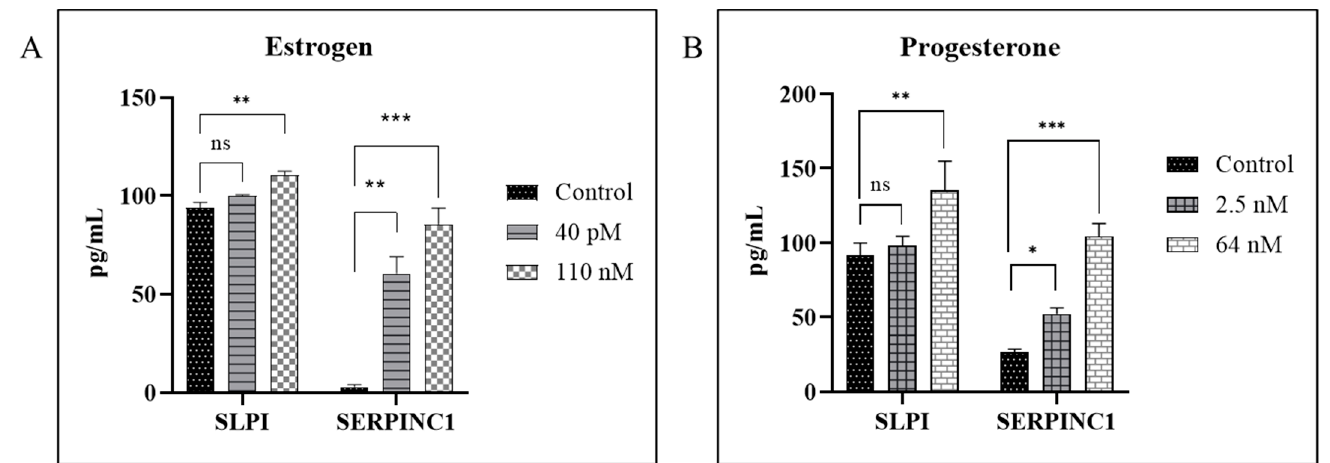
Figure 2. Validation of Protein expression in Estrogen or Progesterone Treated MDMs Infected with HIV-1; BioPlex analysis of secreted Secretory Leukocyte Peptidase Inhibitor (SLPI) and Serine Proteinase Inhibitor Clade C Member 1 (SERPIN C1) in culture supernatants from monocytes derived macrophage cells infected with HIV-1 (BaL) pre-treated with 40 pM or 110 nM estrogen ( A ) or 2.5 nM or 64 nM progesterone ( B ) and not pre-treated with estrogen or progesterone as control. Culture supernatants were analyzed in duplicate; Culture supernatants were analyzed in triplicate. Results expressed as mean ± SEM. This data is representative of three independent donors. Asterisk (*) over the bars indicates significant difference with control; *** p < 0.0001; ** p < 0.001; * p ≤ 0.05 and ns p > 0.05. p -values were generated by one-way ANOVA with multiple comparisons.